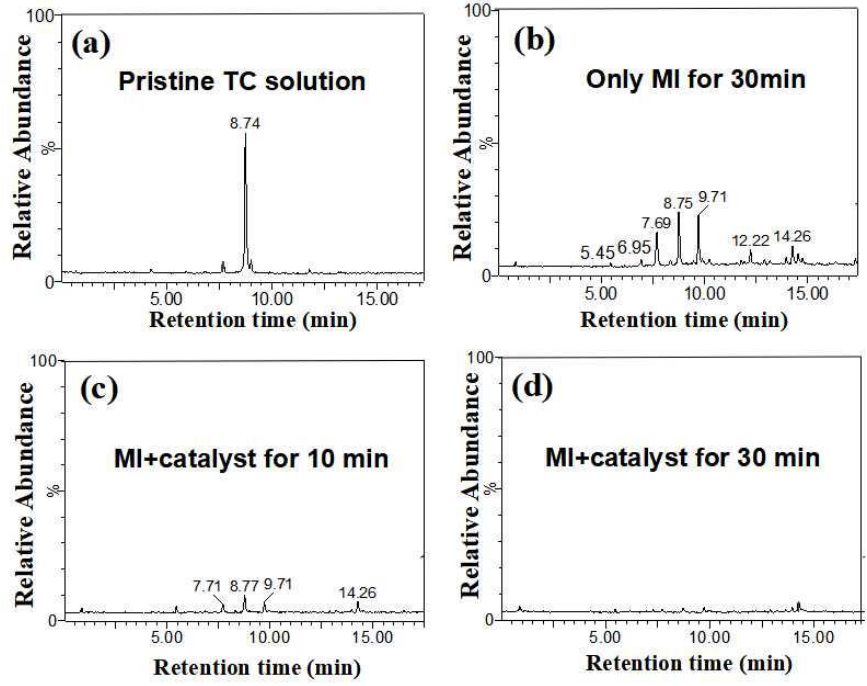
Figure 8. High-performance liquid chromatography of TC ( a ), TC under MI for 30 min ( b ), and TC under MI using MnO/CNTs as catalyst for 10 ( c ) and 30 min ( d ).